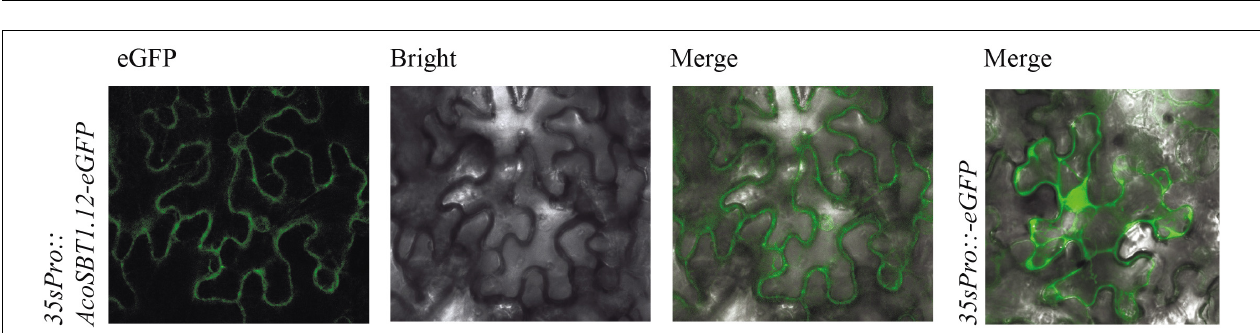
FIGURE 6 | Tissue-specific expression profiles of AcoSBTs in pineapple. Heat-map of tissue-specific expression profiles of AcoSBTs in pineapple. Samples are mentioned at the top of each lane: ovule S1–S7, sepal S1–S4, stamen S1–S5, petal S1–S3, root, leaf, flower, fruit S1–S7. “S” is the abbreviation of the word “stage.”